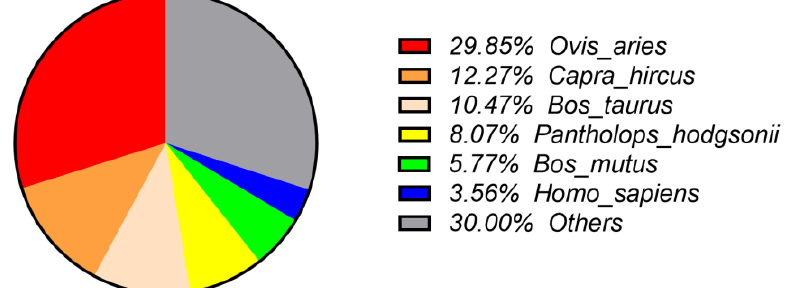
Figure 2. Similarity analysis of unigenes based on the best